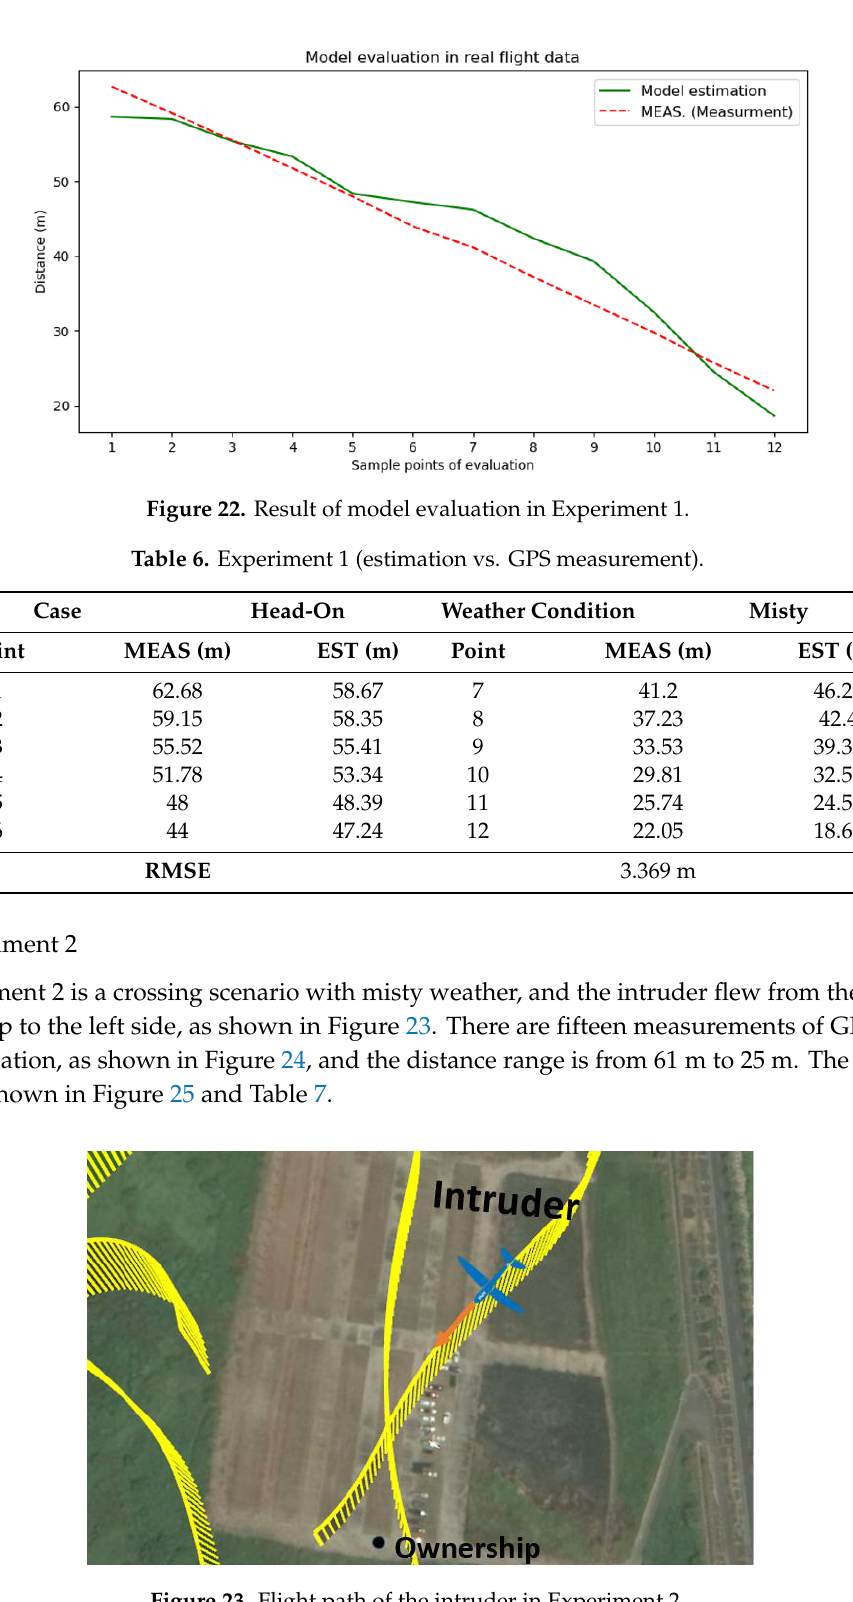
Figure 21. Measurements of global positioning system (GPS) data to evaluate the model in Experiment 1.